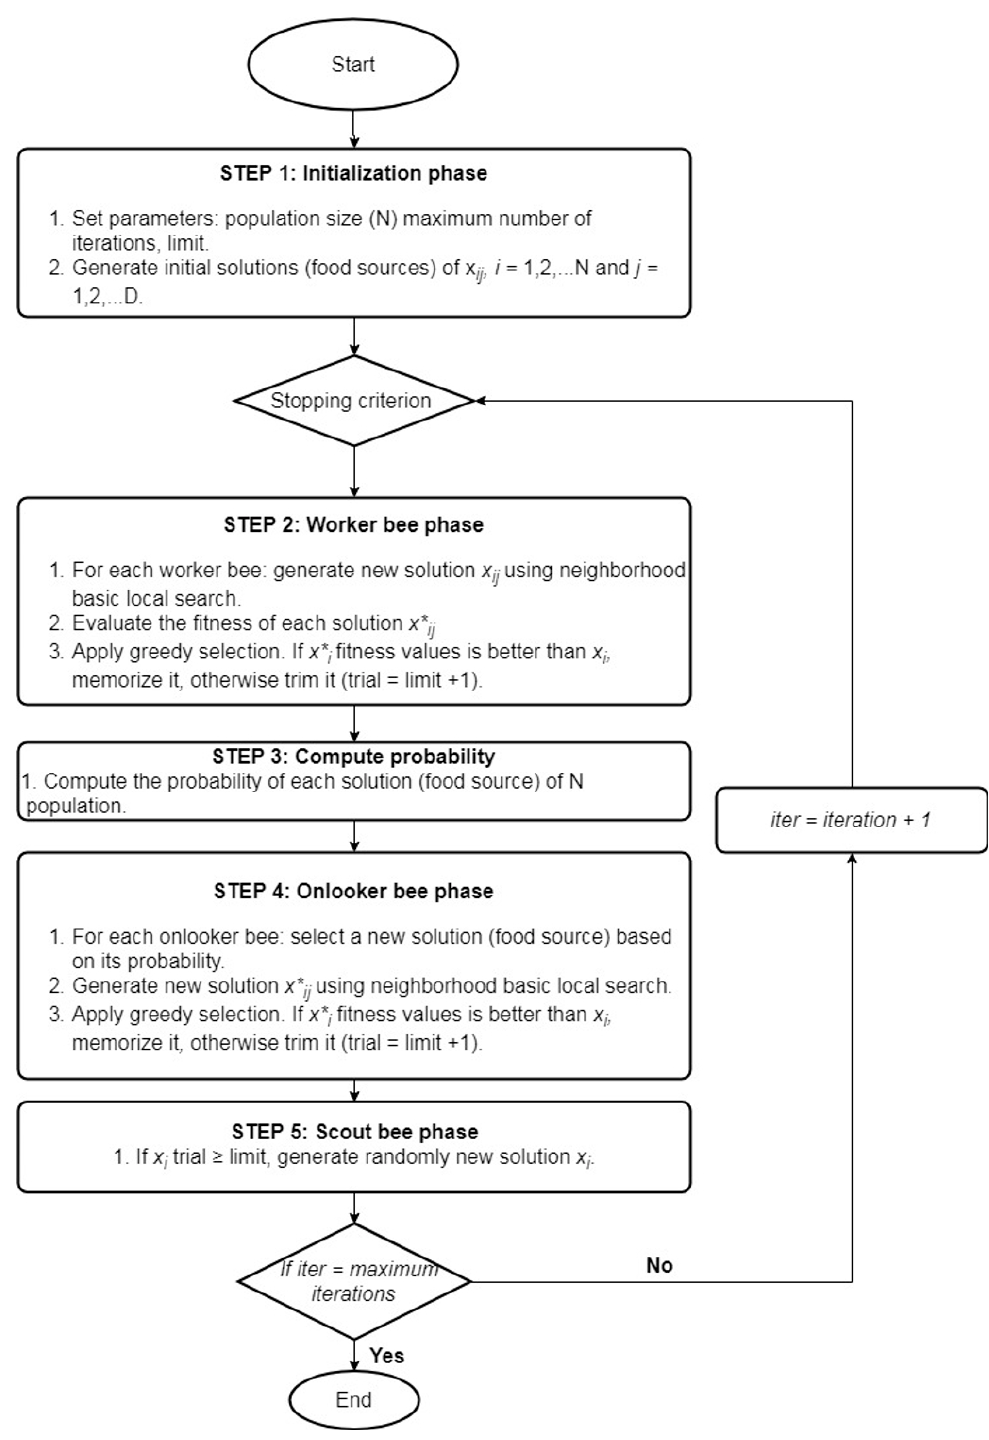
Figure 1. Main steps of Artificial Bee Colony (ABC) algorithm.